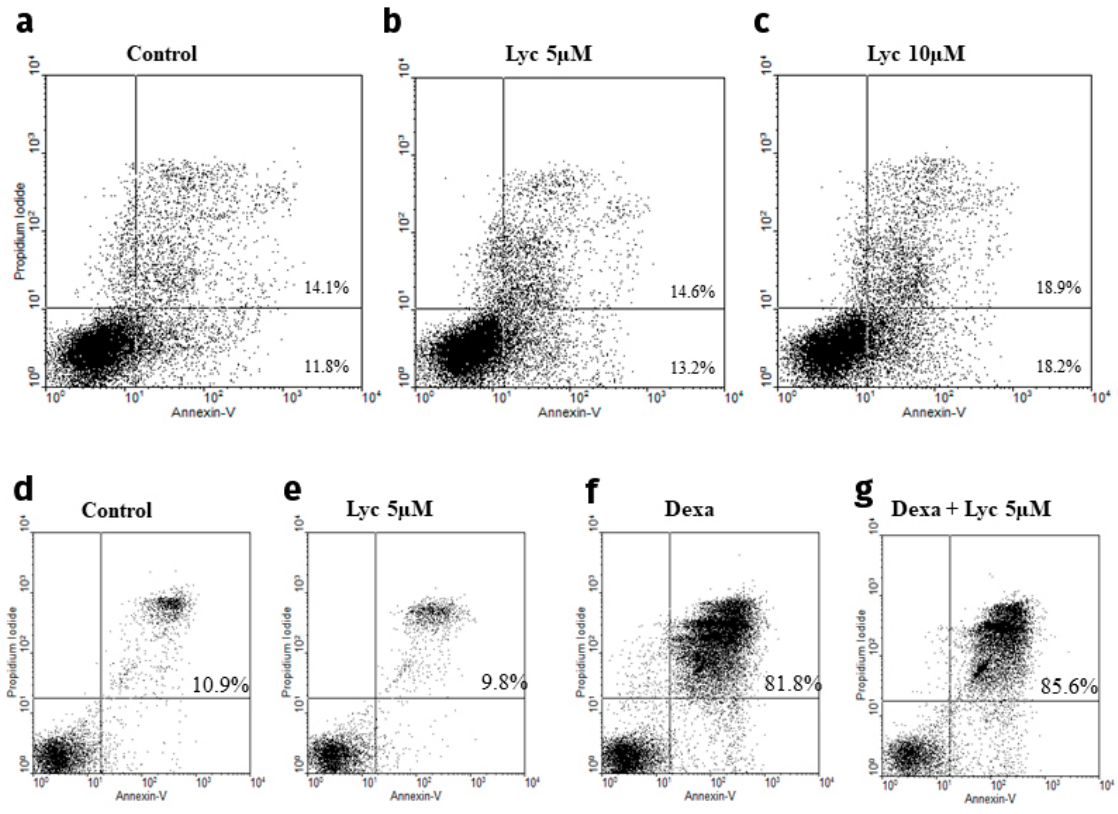
Figure 2. Bone marrow cell viability mediated by lycopene. Annexin-V and propidium iodide were used to